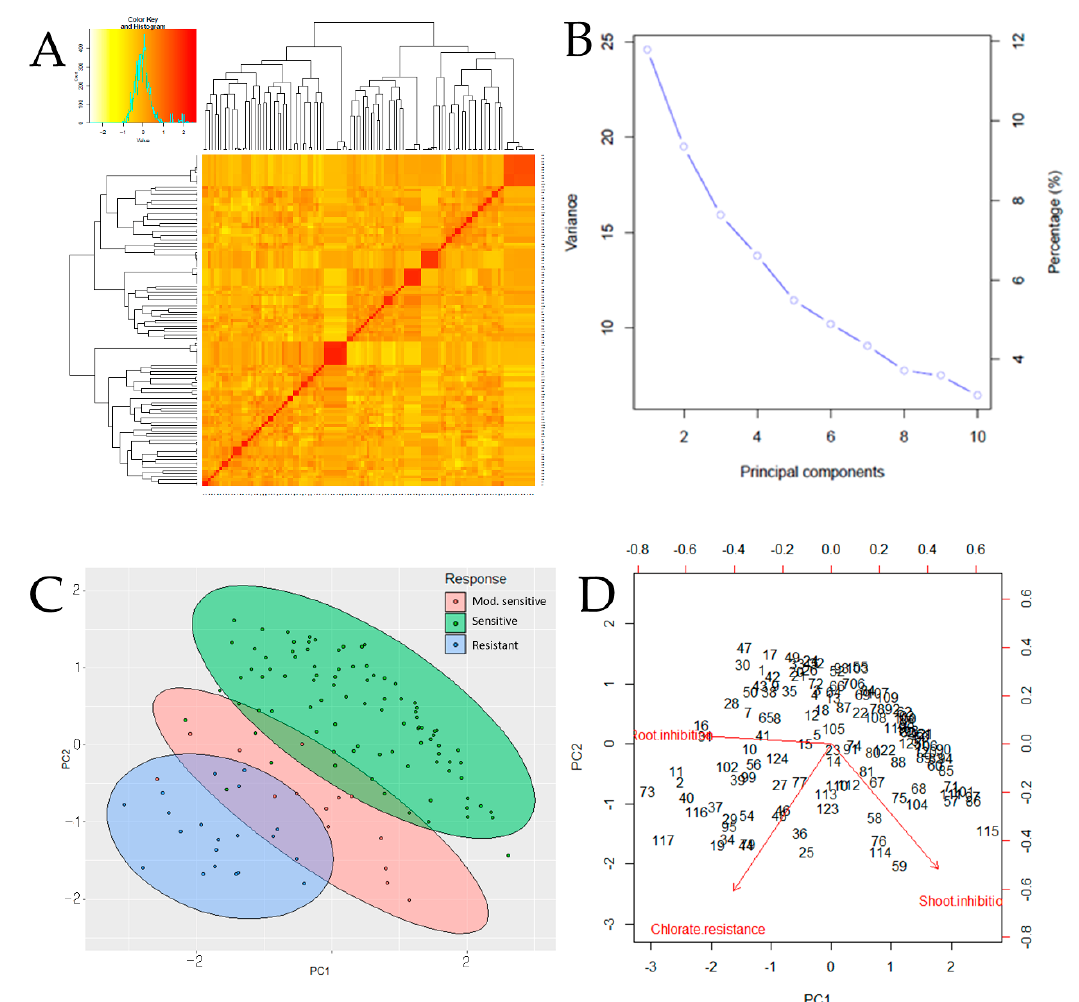
Figure 4. Kinship matrix and principal component analysis (PCA) results. ( A ) The heat map of pairwise kinship matrix values based on 229 Kompetitive Allele-Specific PCR (KASP) markers on 117 rice doubled haploid (DH) lines according to VanRaden algorithm. The color histogram indicates the distribution of coefficients of co-ancestry, with the stronger red color showing the DH lines more related to each other, ( B ) eigenvalue accumulation variance among principal components (PCs) revealed contribution to only 3 PCs, ( C ) graphic scattered plot of PCA of 117 DH lines, calculated from 229 KASP markers and clustered. Resistant, moderately sensitive, and sensitive lines are respectively grouped in blue (bottom ellipse), brown (middle ellipse), and green (top ellipse), and ( D ) principal components with correlation between variables.